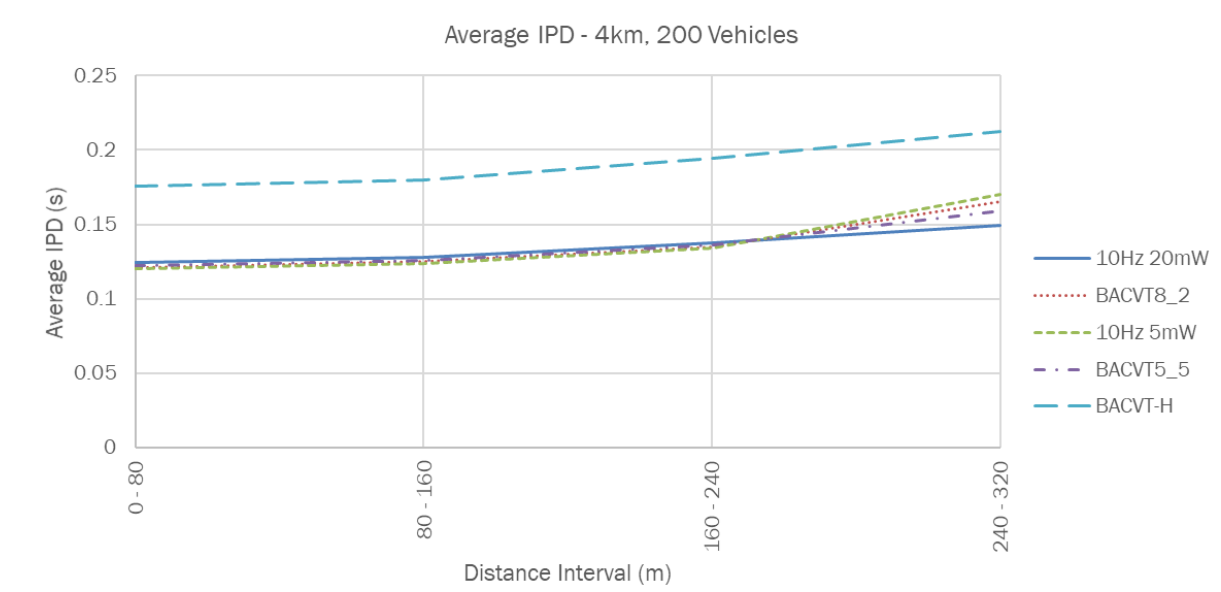
Figure 10. IPD in high vehicle